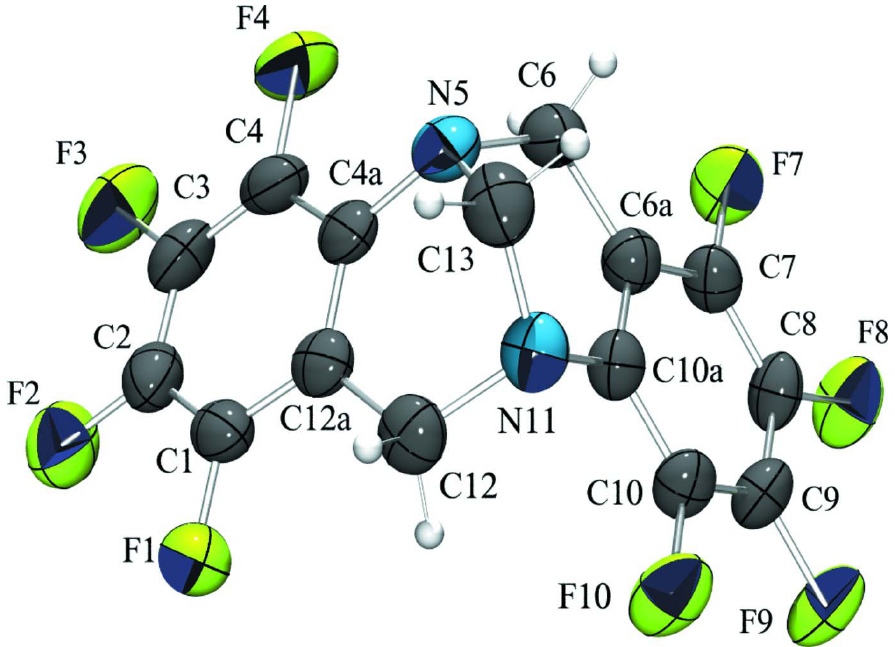
Figure 1 View of the structure with 50% probability displacement ellipsoids. H atoms are numbered according to their attached C-